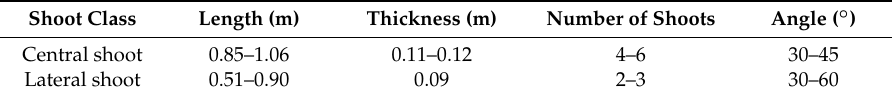
Table 1. The major structural parameters of a Muluo